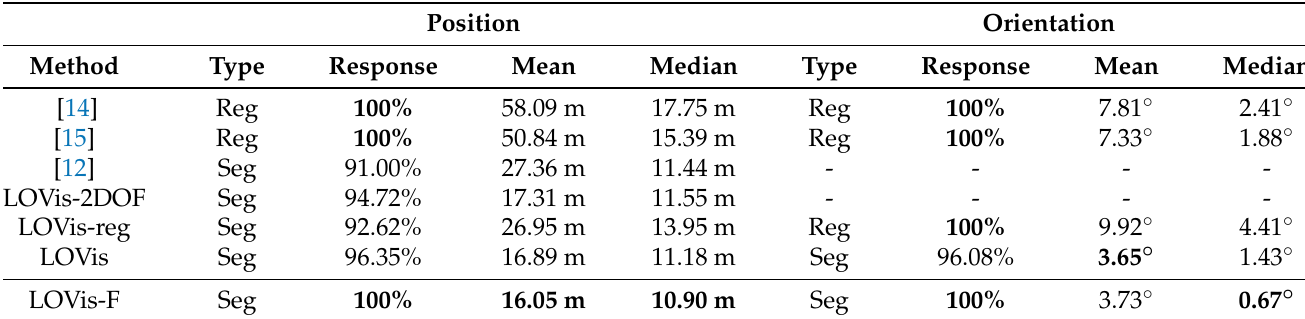
Table 2. Results for 3-DOF pose prediction. Note how the segmentation formulation (Seg) is superior to the regression one (Reg) for both position and orientation learning. The best performances are shown in bold. Position Orientation